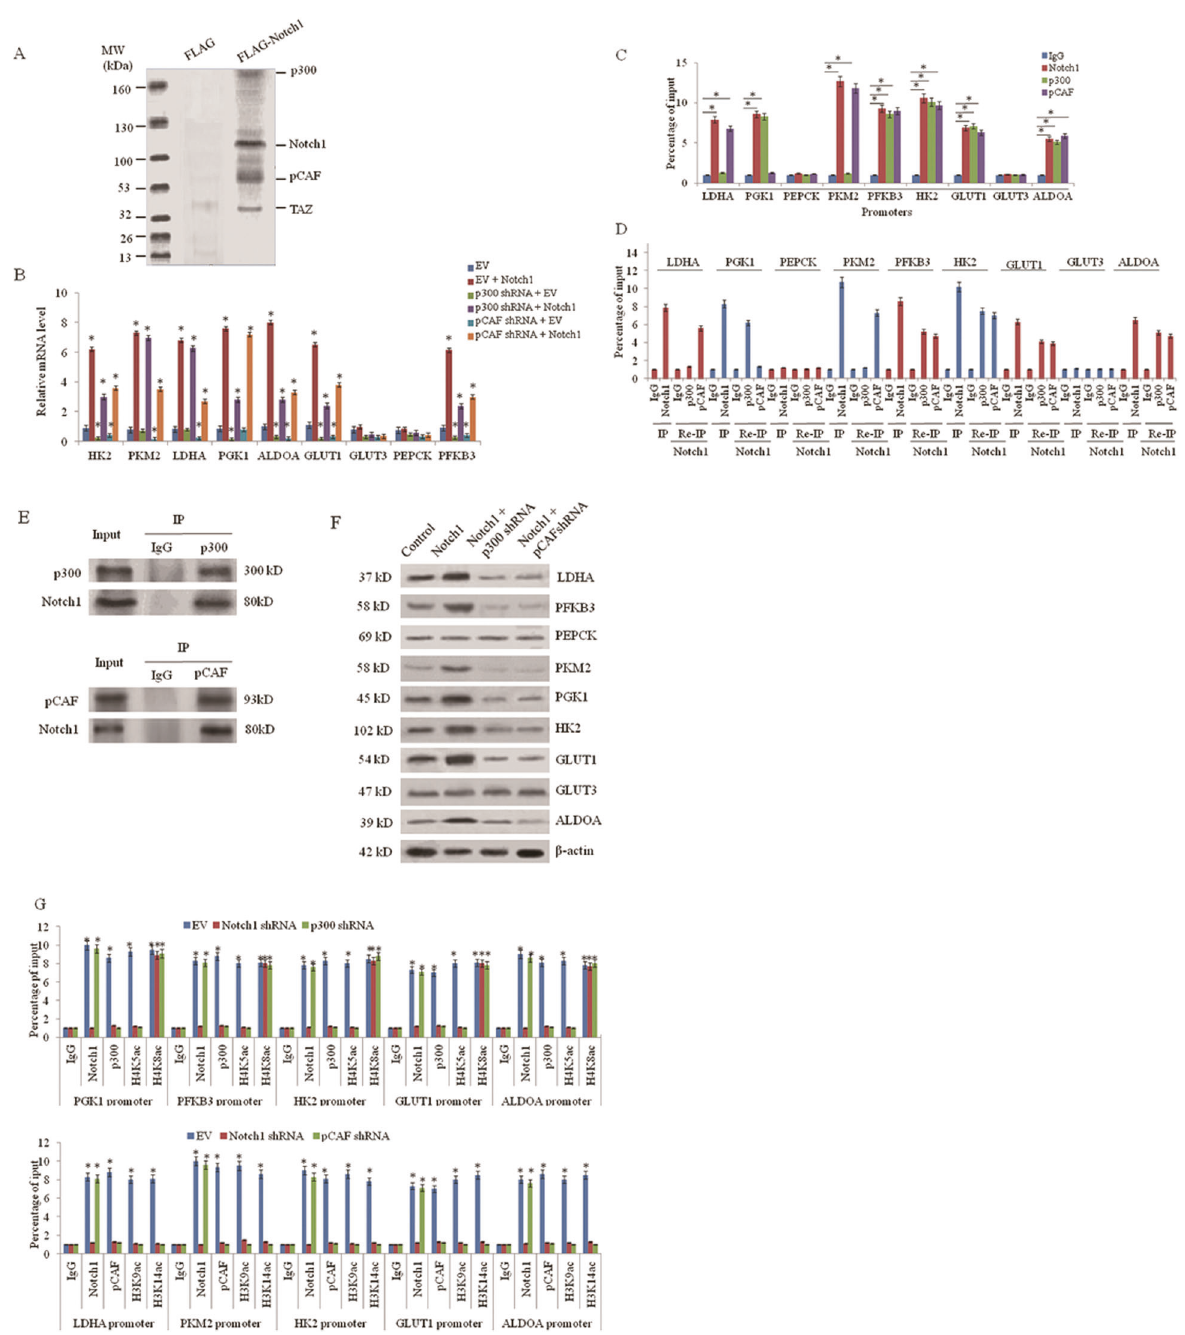
Fig. 2 Notch1 promotes glycolytic gene expression through functional interaction with p300 and pCAF. a Cellular extracts from A549 cells stably expressing FLAG (control) or FLAG-Notch1 were immunopuri fi ed with anti-FLAG af fi nity columns and eluted with FLAG peptide. The eluates were resolved by SDS-PAGE and silver stained. The differential protein bands were retrieved and analyzed by mass spectrometry. b A549 cells were transfected with Notch1 ICD, p300 shRNA, pCAF shRNA, or empty vector (EV). Glycolytic gene expression was measured using qRT-PCR. * P < 0.05. c ChIP analysis of Notch1, p300, and pCAF occupancy on glycolytic gene promoters in A549 cells. The graph shows the percentage of input. d Re-ChIP analysis of the occupancy of Notch1 and p300 or pCAF on the glycolytic gene promoters in A549 cells. e A549 cells were immunoprecipitated with anti-p300, anti-pCAF, or normal IgG, and the precipitates were analyzed by immunoblot with the indicated antibodies. IP immunoprecipitation. f A549 cells stably transfected with Notch1 were co-transfected p300 shRNA or pCAF shRNA. The protein expression of glycolytic genes was examined using western blot assay. g Notch1, p300, pCAF, and histone H3 and H4 acetylation occupancy on the promoters of indicated glycolytic genes in A549 cells transfected with Notch1 shRNA, p300 shRNA or pCAF shRNA was examined using ChIP